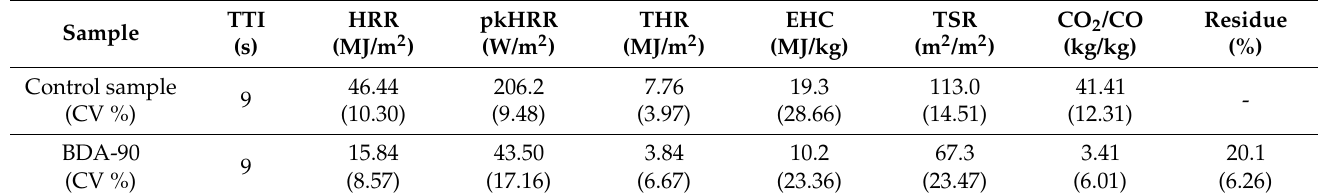
Figure 5. Photographs of vertical burning test of the control sample: ( a ) BDA-30; ( b ) BDA-60; ( c ) BDA-90; ( d ) BDA-120; ( e ) treated samples (3 curing time, 50 LCs). Table 2. LOI data of BDA treated samples (3 curing times) after 1–50 laundering